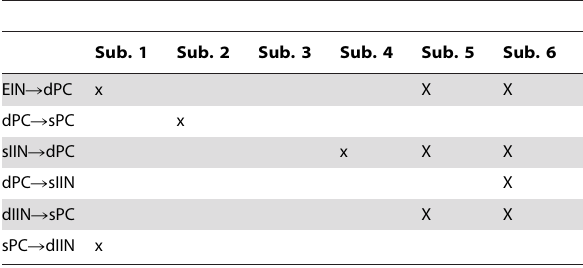
Table 2. Estimated ‘‘uncertain‘‘ connections. Non-zero connections are marked with ‘‘X’’.